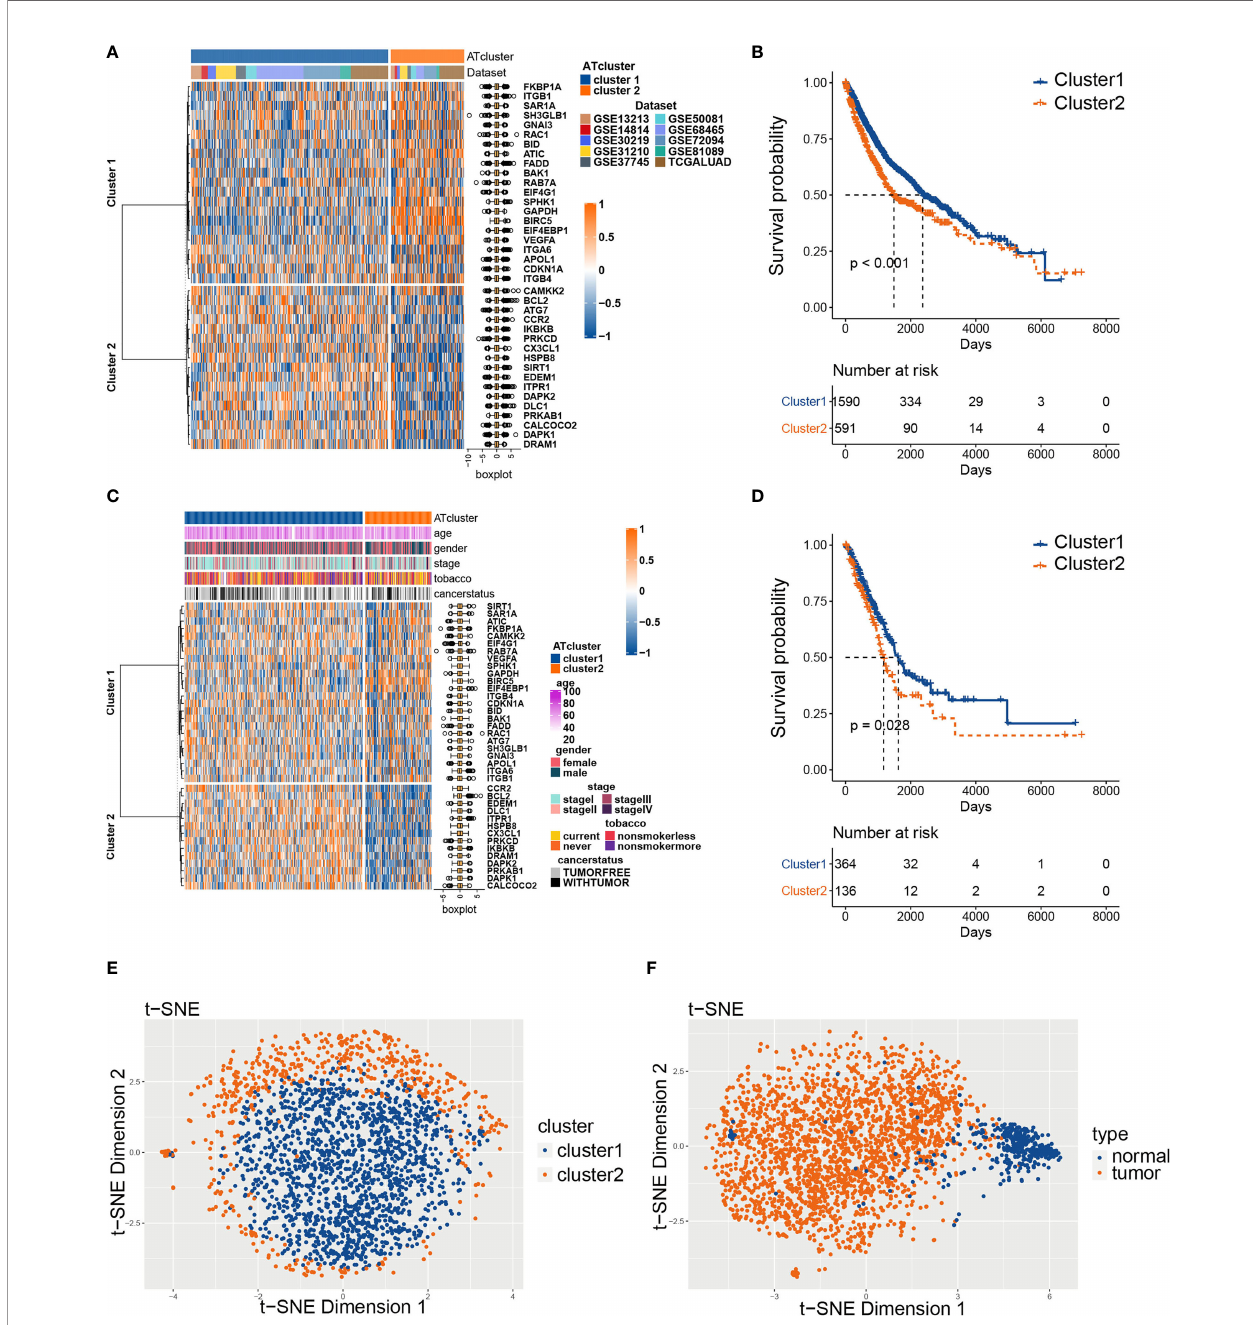
FIGURE 2 | The consensus clustering of autophagy regulators predicted the prognosis of LUAD patients. The expression pattern of 38 autophagy regulators in the meta-cohort (A) and TCGA cohort (C) . The heatmaps showed upregulated genes (red) and downregulated genes (blue) of autophagy regulators in subgroups. The Kaplan ‐ Meier analysis showed that the clusters2 had worse prognosis than cluster1 in both meta-cohort (B) and TCGA cohort (D) . The t-SNE analyses showed that the two autophagy clusters were fi ne isolated (E) , and the autophagy-related regulators separated tumors from normal tissues noticeably (F)